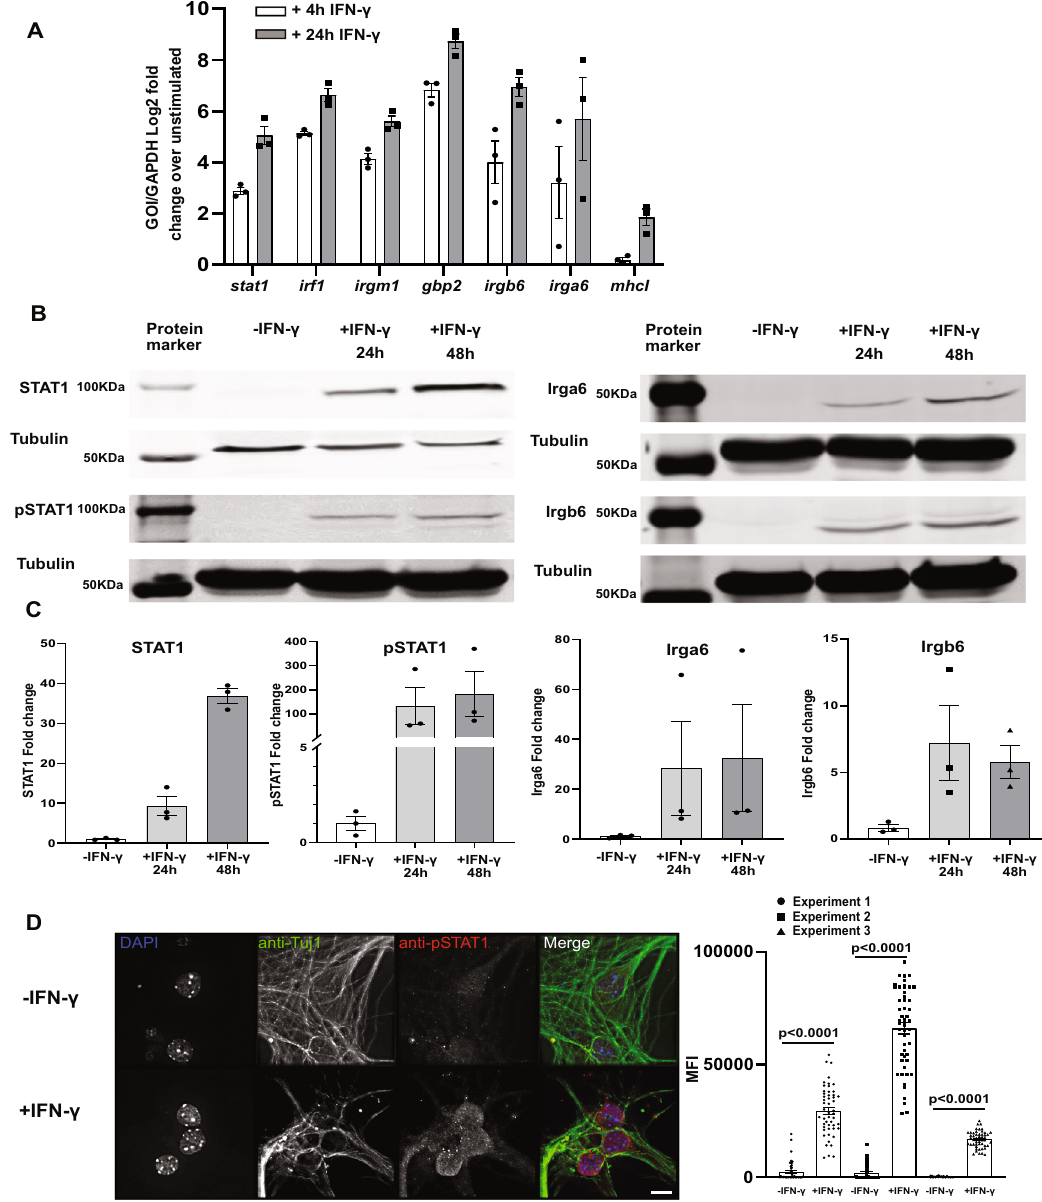
Fig. 1 | IFN- γ stimulated primary murine neurons show intact IFN- γ signaling pathway and express genes involved in T. gondii clearance. Primary neurons cultures were stimulated with vehicle or IFN- γ (100 U/ml), followed by RNA or protein extraction or immuno fl uorescent assays. A Quanti fi cation of speci fi ed genes using qRT-PCR. B Representative images of western blots for speci fi ed proteins from unstimulated and IFN- γ stimulated cultures. C Densitometric quan- ti fi cationofwesternblots.Proteinsofinterestarenormalizedto β -tubulinandthen shownasafoldchangeoverunstimulatedcultures.For A , C Bars,mean±SEM. N =3